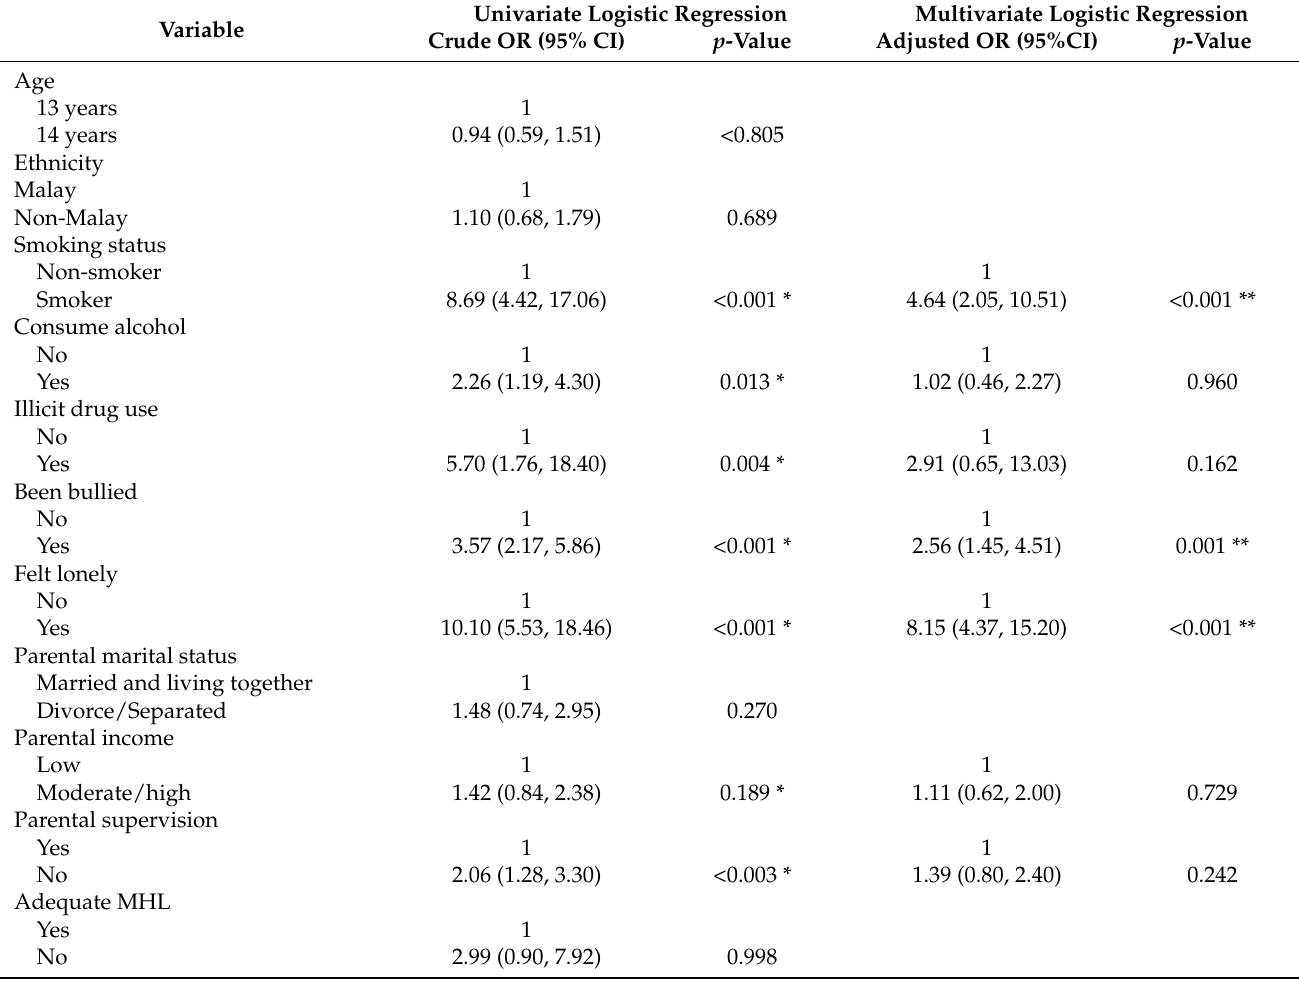
Table 4. Factors associated with depressive symptoms among males ( n =